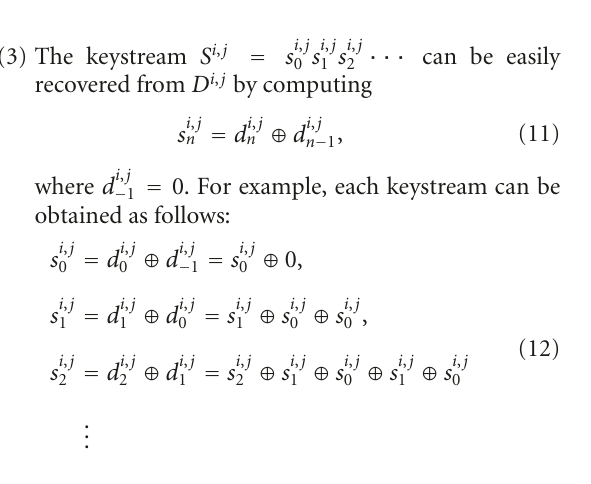
Figure 2: Flowchart of chosen-plaintext attack